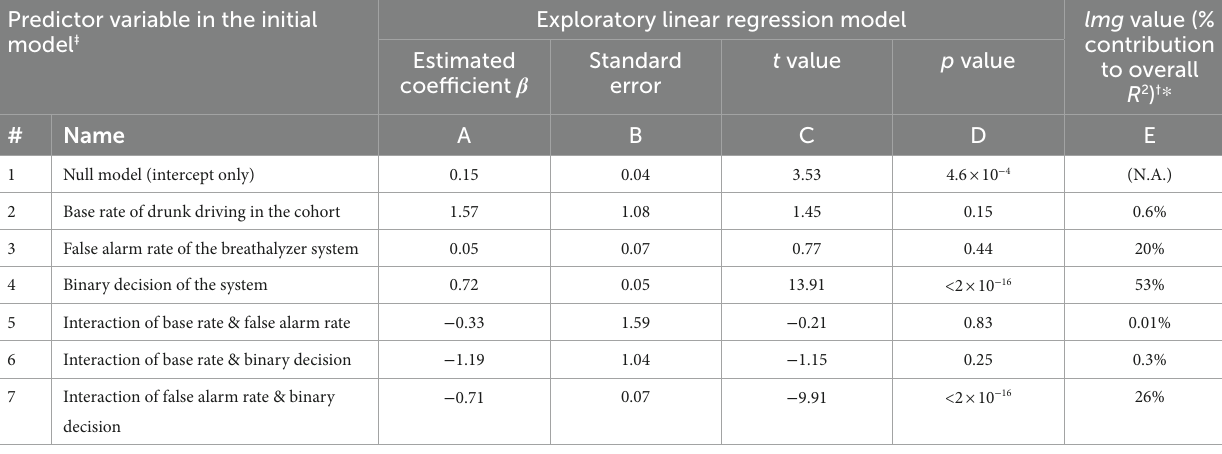
TABLE 2 Summary of regression modeling of the reported probabilities in Experiment